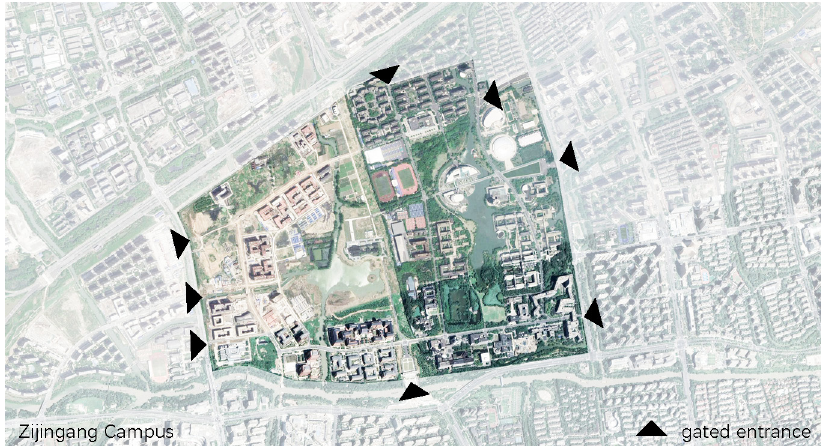
Figure A1. Zijingang Campus plan of Zhejiang University (photo taken on 23 September 2019).